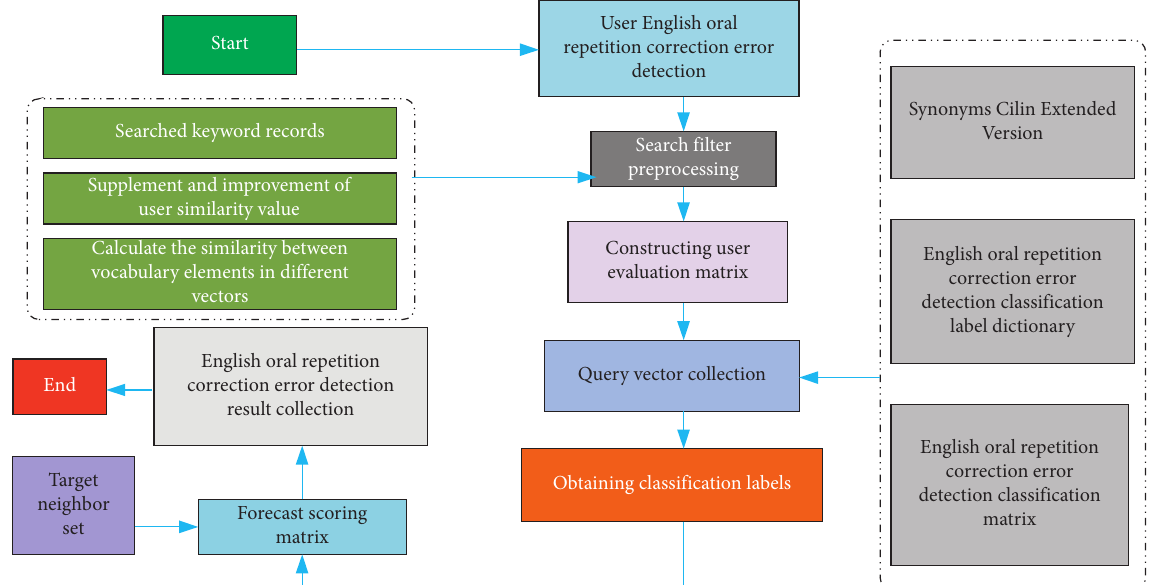
Figure 2: The overall design framework of search filtering algorithm based on user search